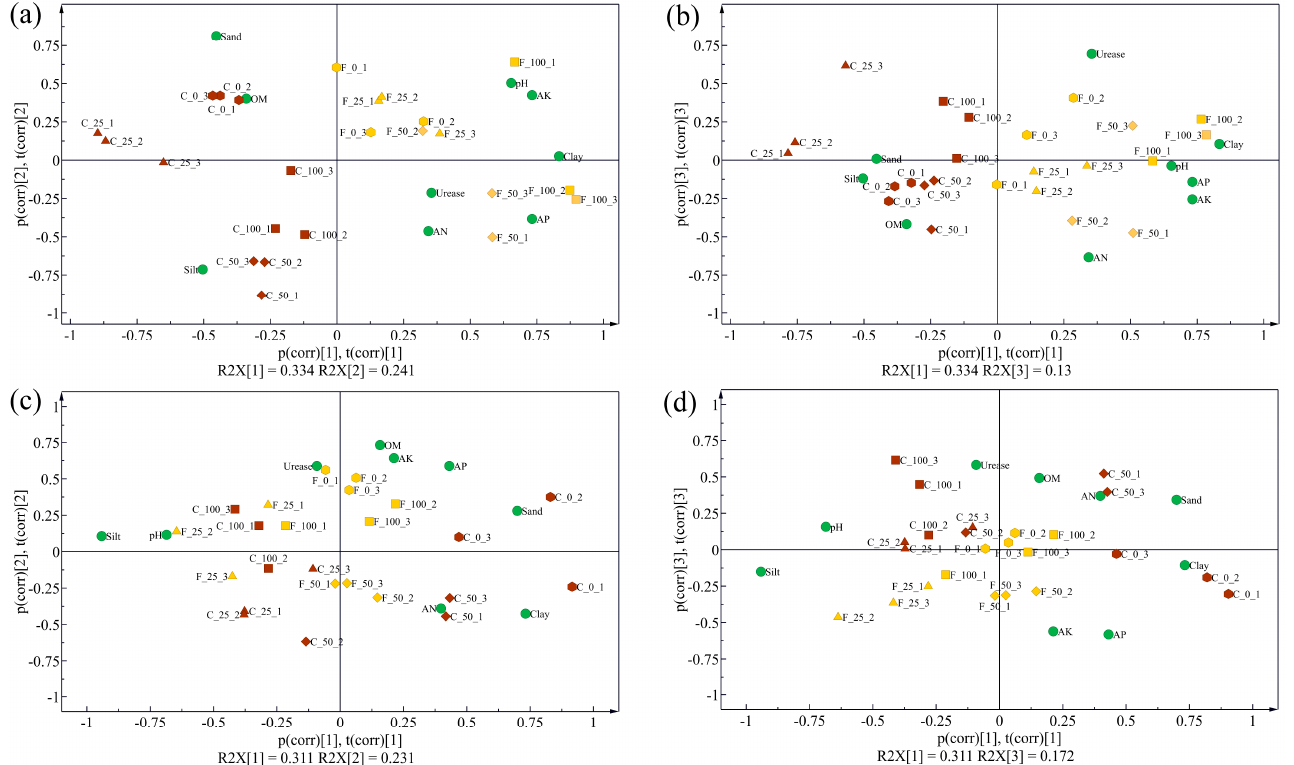
Figure 1. Biplots of the principal component analysis models of the physical and chemical properties of cassava rhizosphere soil samples collected in 2019 ( a , b ) and 2020 ( c , d ), respectively. The sample ID was named ‘tillage_N rates_replicate’, and C and F represent conventional tillage and Fenlong tillage, respectively. OM, organic matter; AN, available nitrogen; AP, available phosphorus; AK, available potassium. Table 2. ANOVA and paired t -test of the fungal richness and diversity indices of cassava rhizosphere soil collected in 2019 and 2020, respectively.